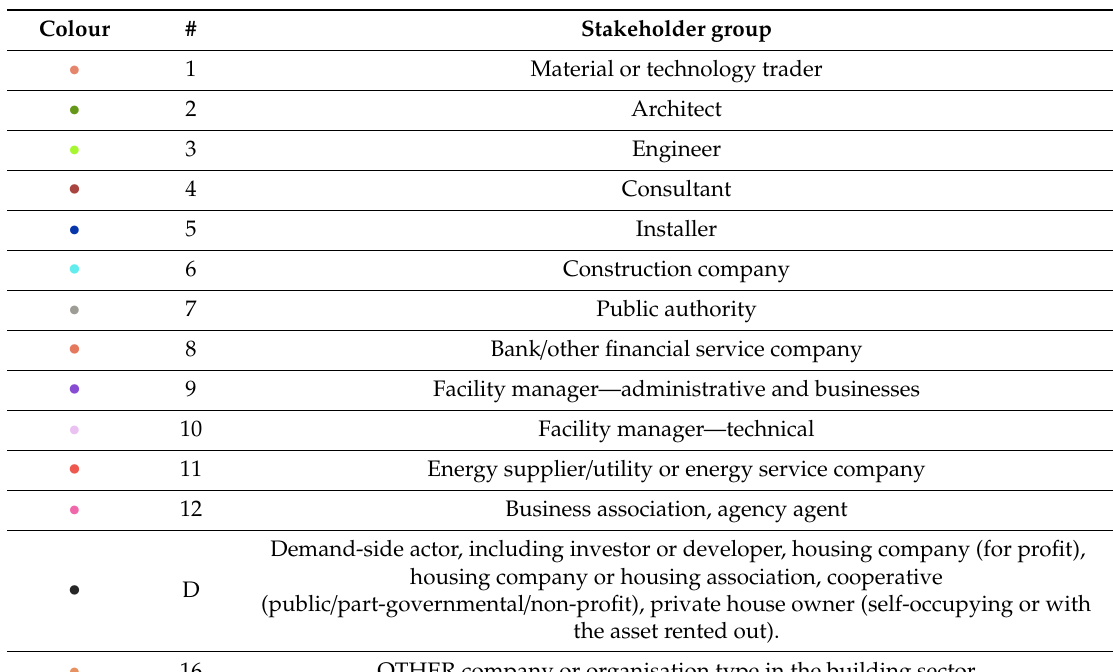
Table 3. Stakeholder group